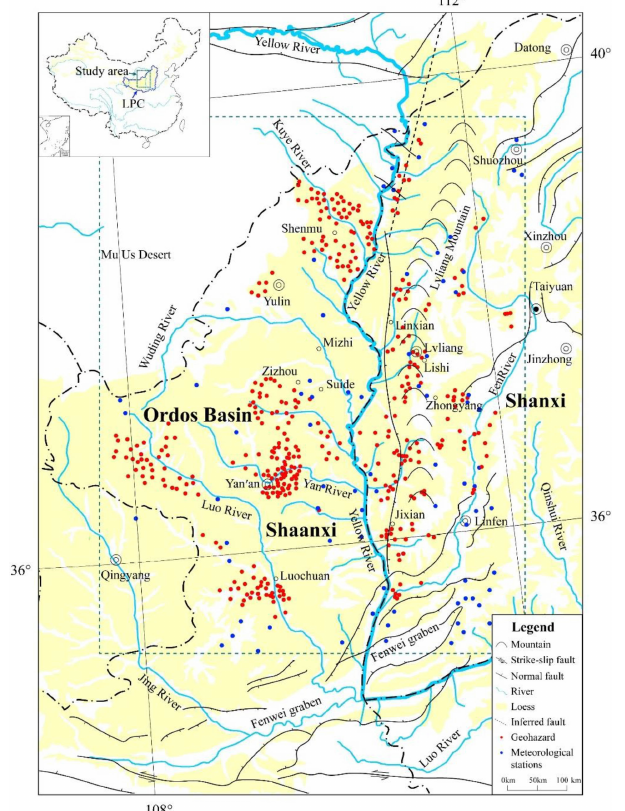
Figure 2. Geological map of the study area. The red dots denote the cracking–sliding failure cases and the blue dots indicate the meteo- rological stations in the study area.